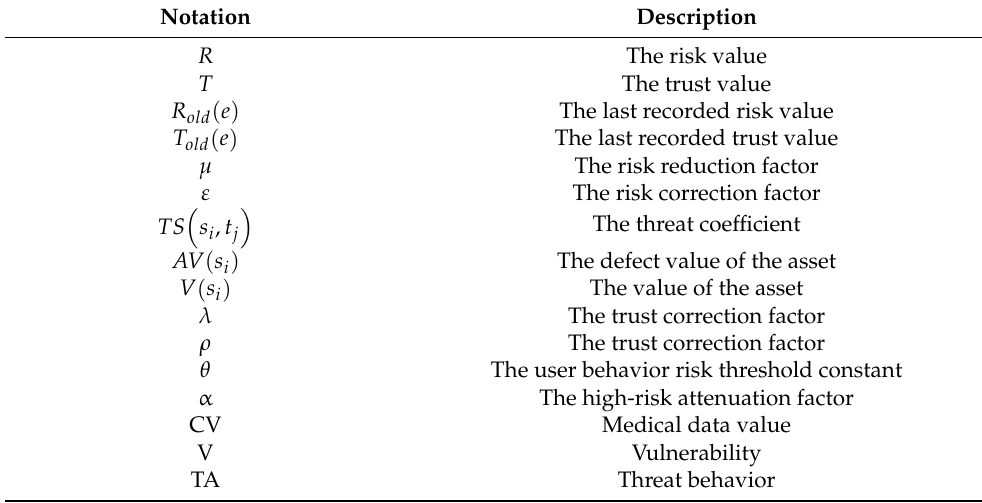
Table 1. Summary of notations and